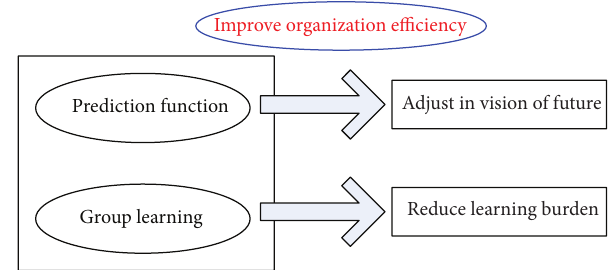
Figure 1: Organization